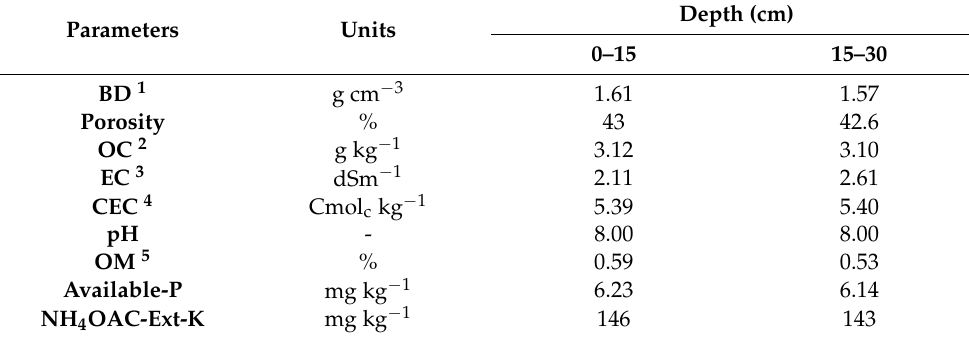
Table 1. Initial soil physicochemical properties before experimentation.